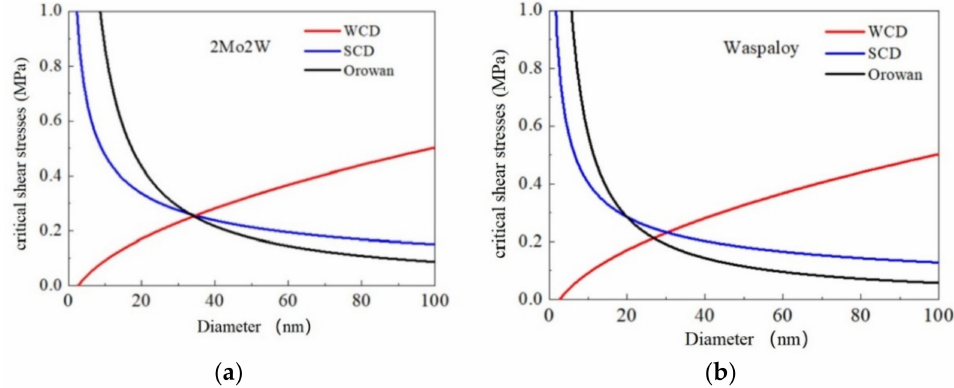
Figure 10. Fitting curves of theoretical critical shear stress versus diameter of the γ (cid:48) phase for 2Mo2W ( a ) and Waspaloy ( b ) at 700 ◦